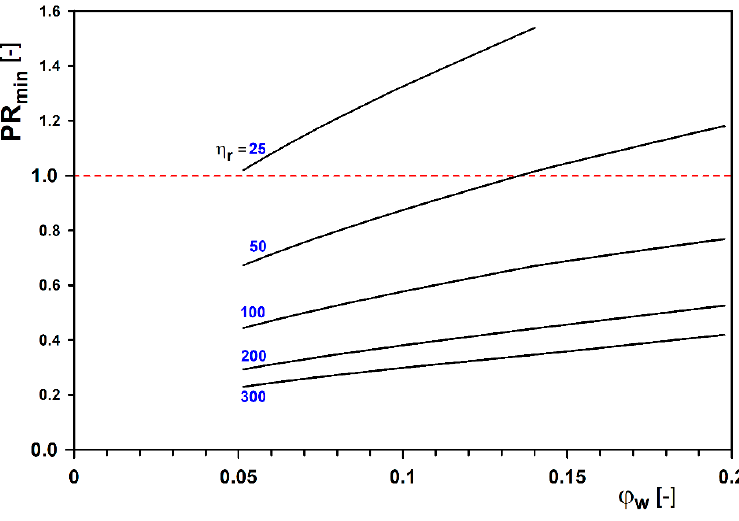
Figure 11. Smallest viable values of PR for oils with various viscosities.